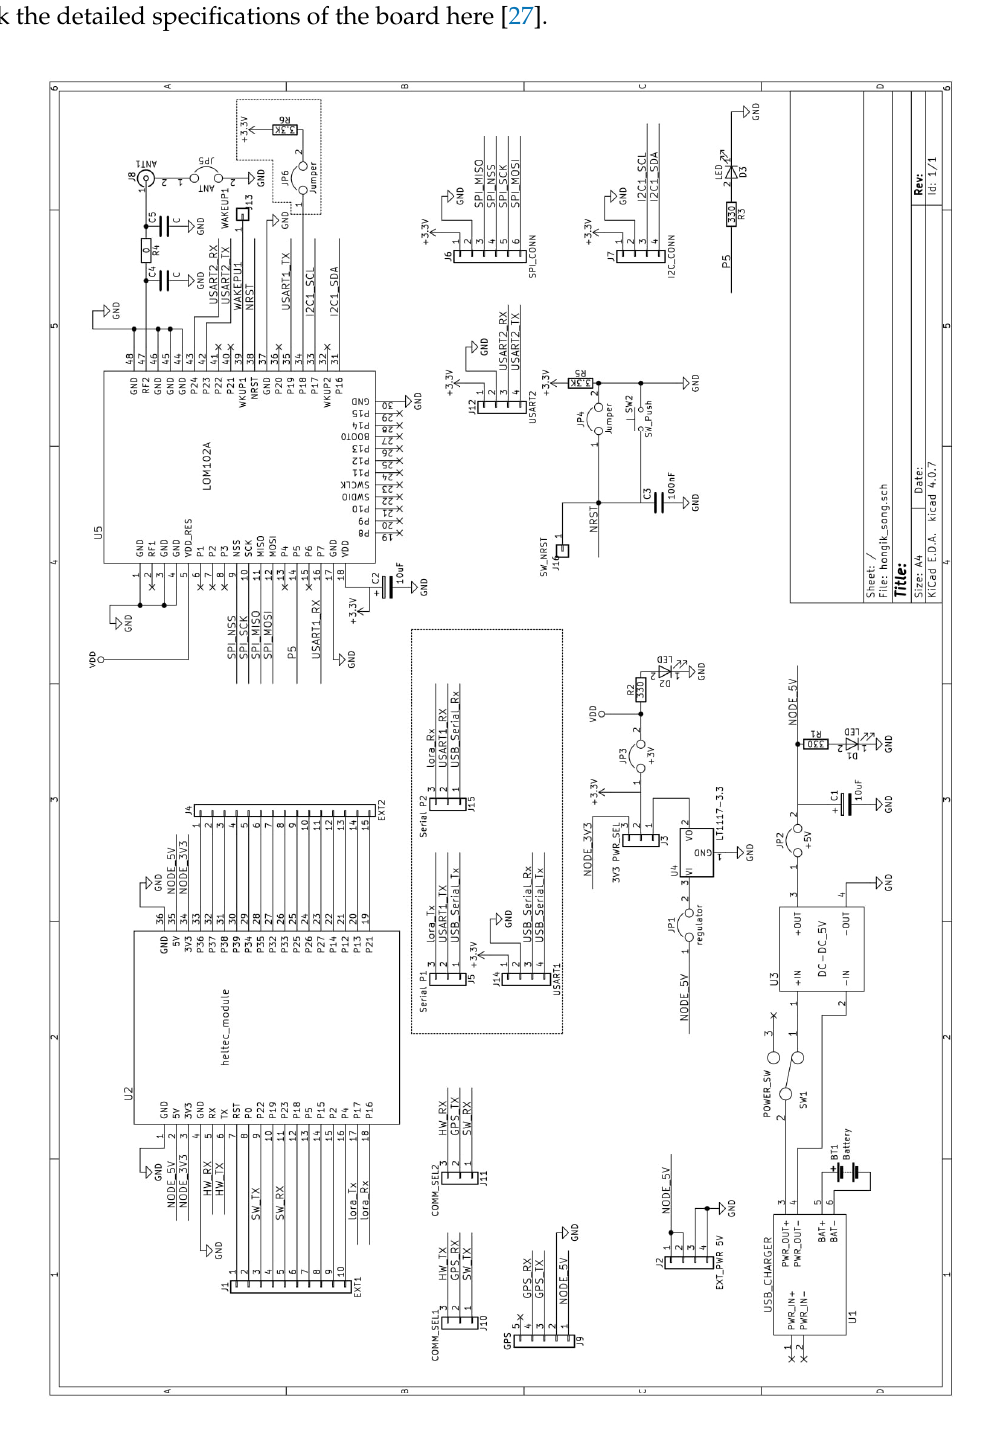
Figure 5. Schematic diagram of an IoT